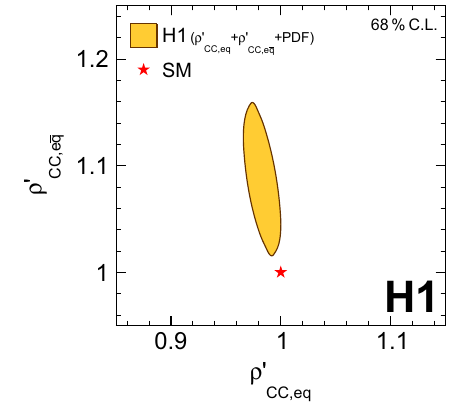
Fig. 6 Results for the ρ (cid:6) dence level (CL) obtained with the ρ (cid:6)